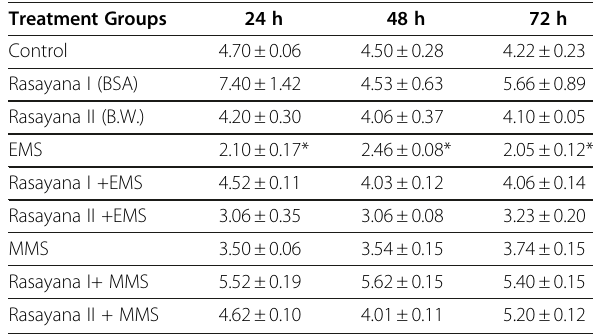
Table 1 Mitotic Indices in mouse bone marrow cells of Brahmarasayana and EMS- or MMS- treated groups at